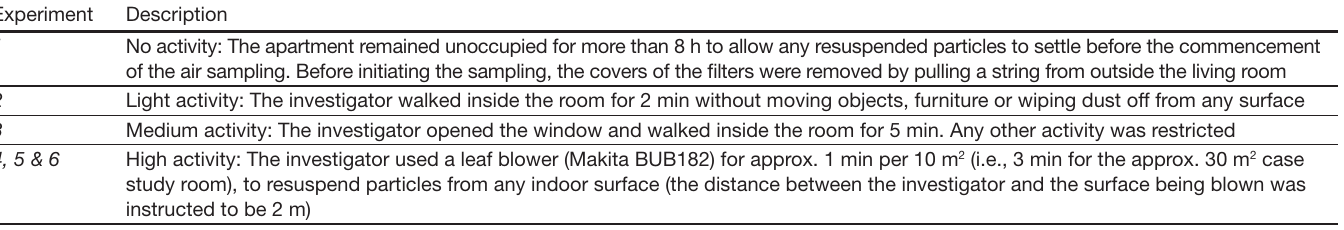
Figure 5 Floor plan of the case study living room (Source: Authors, 2022.)